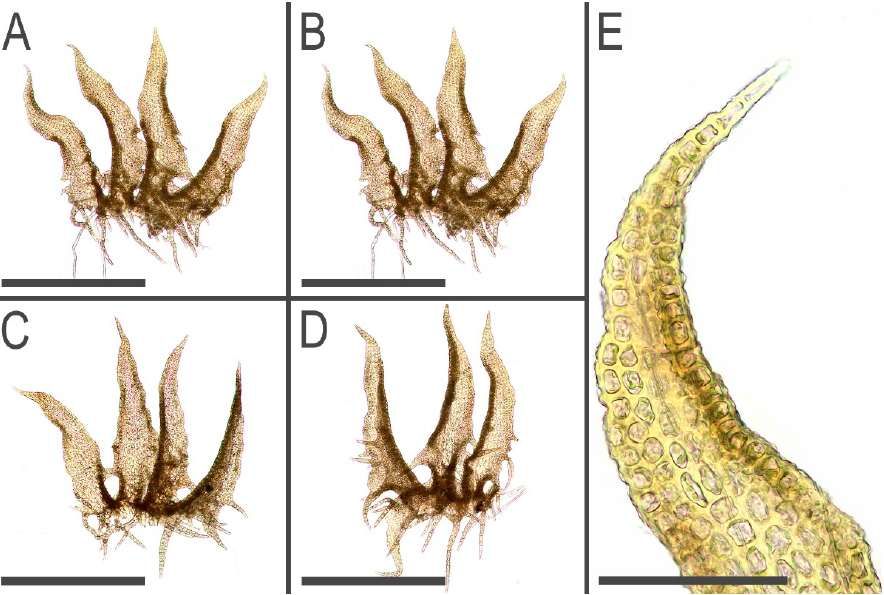
Figure 8. Tetralophozia filiformis (Steph.) Urmi: A – D —leaves; E —leaf lobe apex. Scales: A – D —500 µm; E —100 µm. All from C-39-1-17 (VBGI).